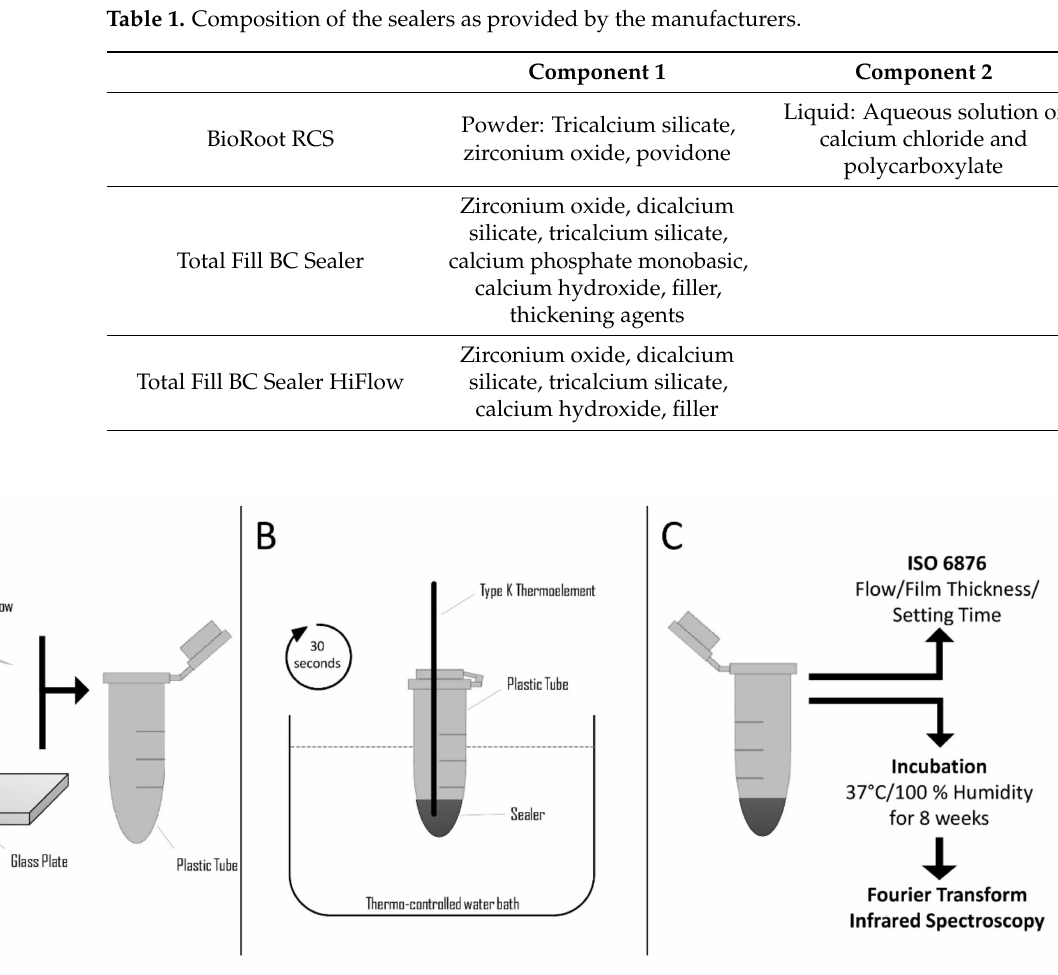
Figure 1. Schematic description of the experimental setup; ( A ): Total Fill BC Sealer and Total Fill BC Sealer HiFlow were dispensed directly to the vial. Mixing of BioRoot RCS and dispensing to plastic vial; ( B ): Thermal treatment of the Sealer; ( C ): Assessment of the physical and chemical characteristics of the sealers